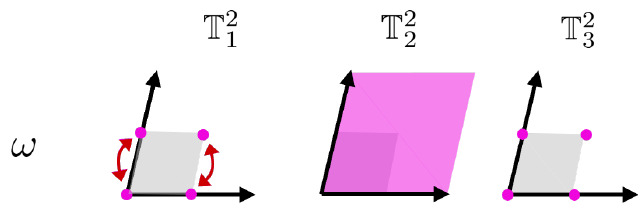
Figure 15 . An illustration of the fixed points (pink) in the Z 2 × Z 2 − 1 − 3